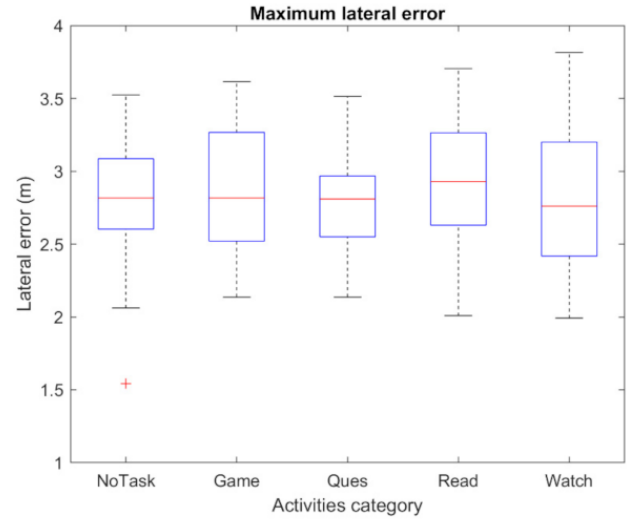
Figure 10. Maximum lateral error achieving. An outlier is presented with the plus sign which represents a high concentration level of the driver during the road checking task.